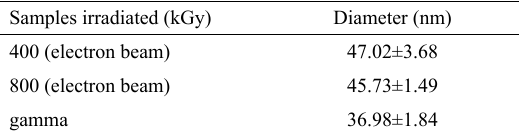
Figure 5. SEM images of CNT yarn gamma irradiated at 100 kGy. Table 1. Diameter of CNTY irradiated